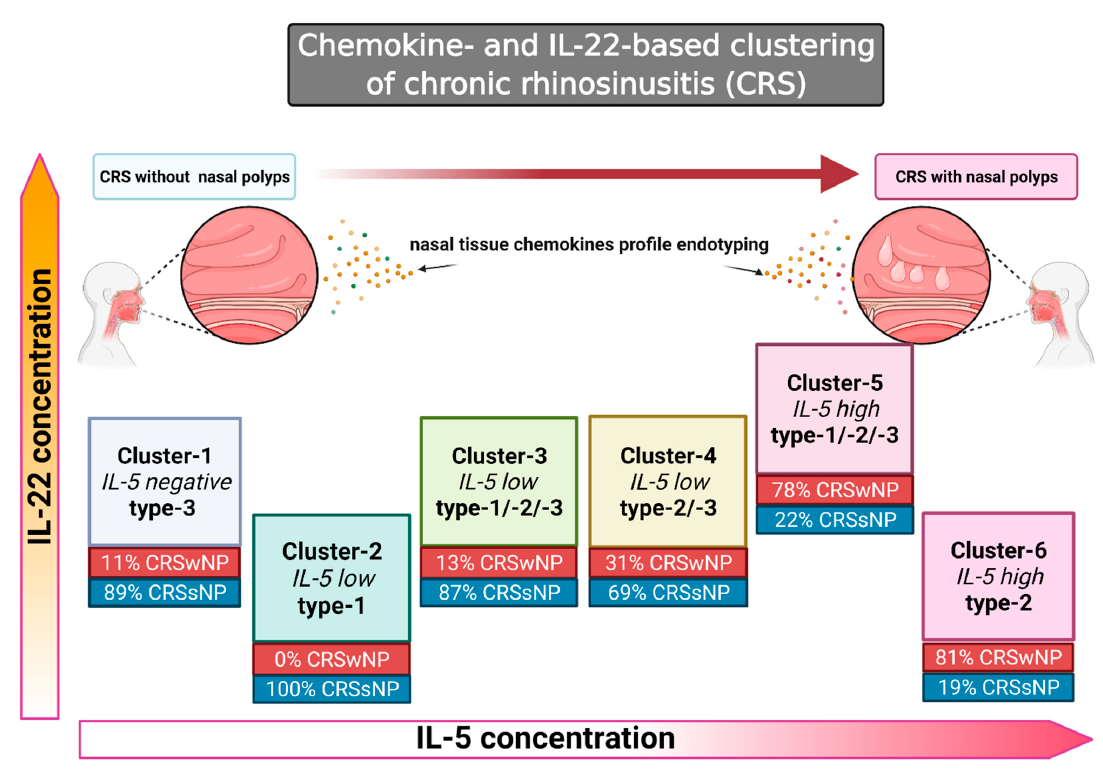
Figure 1. Graphical representation of clusters distribution in relation to the concentration of IL-5 and IL-22 and the occurrence of nasal polyps in the studied cohort of patients with CRS. Created with BioRender.com (accessed on 4 February 2022).